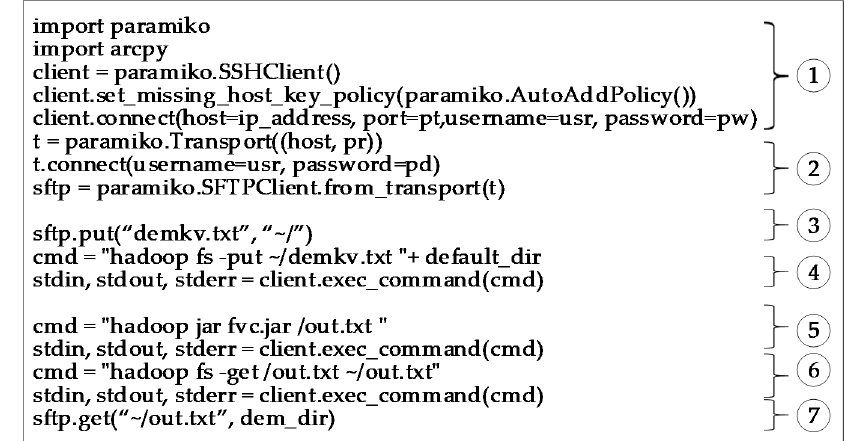
Figure 9. The calculation pipeline of the framework: connection with master node by SSHClient and SFTPClient in ○ 1 and ○ 2 ; uploading the input data to master node in ○ 3 and Hadoop HDFS in ○ 4 ; the model calculation in ○ 5 , and the output data download to master node in ○ 6 and local machine in ○ 7 from HDFS.